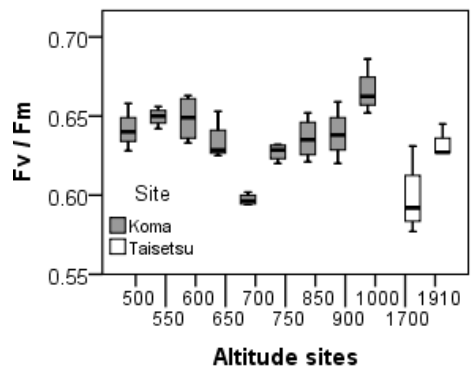
Figure 3. Box plots of Fv/Fm in R. lanuginosum from 11 different sites in Japan, after being exposed to short-term (12 days) temperature treatment ex situ . The median in the box plot is indicated by the horizontal line in the box, the box indicates the 25th and 75th percentiles and the bars indicate the 10th and 90th percentiles. Samples from Mt. Koma (altitude 500–1000 m above sea level) and Taisetsu (altitude 1700 and 1910 m above sea level). n = 4 (3 for altitude site 550). Effects of temperature treatments were non-significant (Table 3).